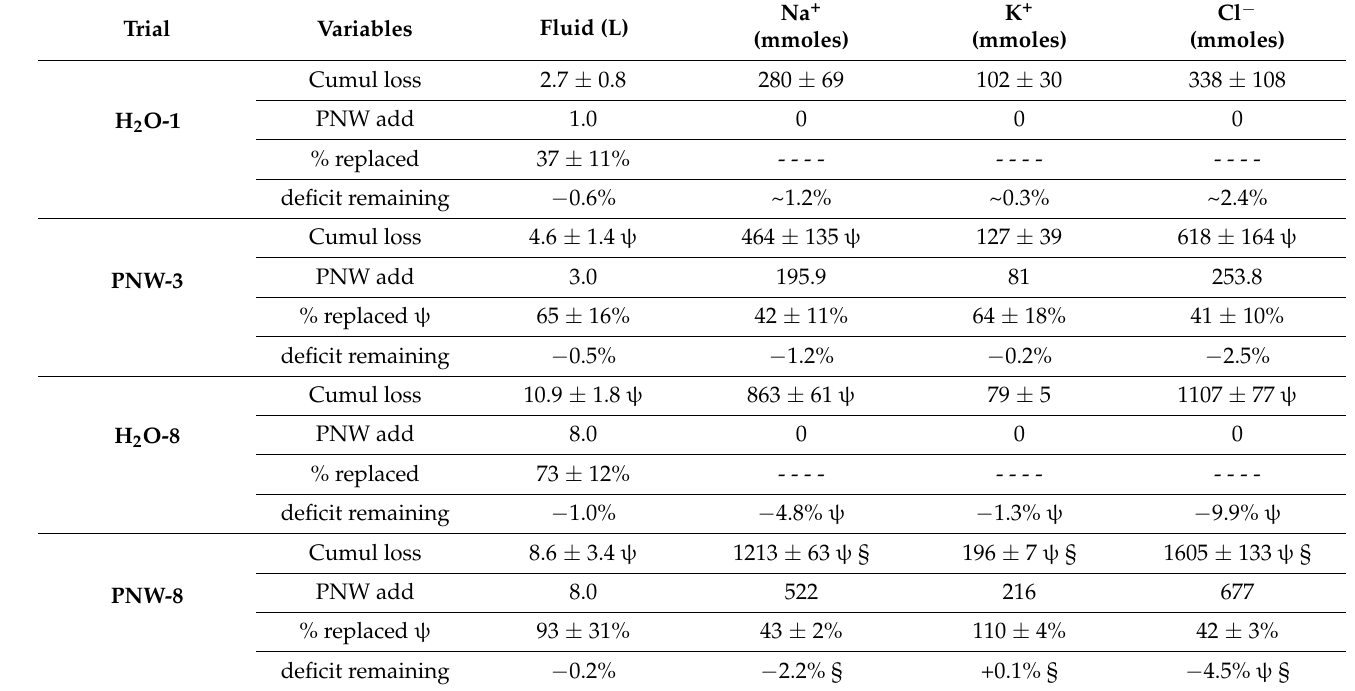
Table 3. Cumulative exercise-induced whole body losses of fluid and ions and the amounts replen- ished during the Low Intensity Time to Fatigue Trial (top), and Moderate Intensity Standardized 45-min Exercise Trials (bottom). Values are Mean ± SEM for n = 4 horses. Cumul = cumulative whole body ion loss over the entire period of sweating (ie; until ~20 min of recovery). Deficit remaining = total body deficit. Ψ , § indicate significantly different from the H 2 O-1 and H 2 O-8 trials,